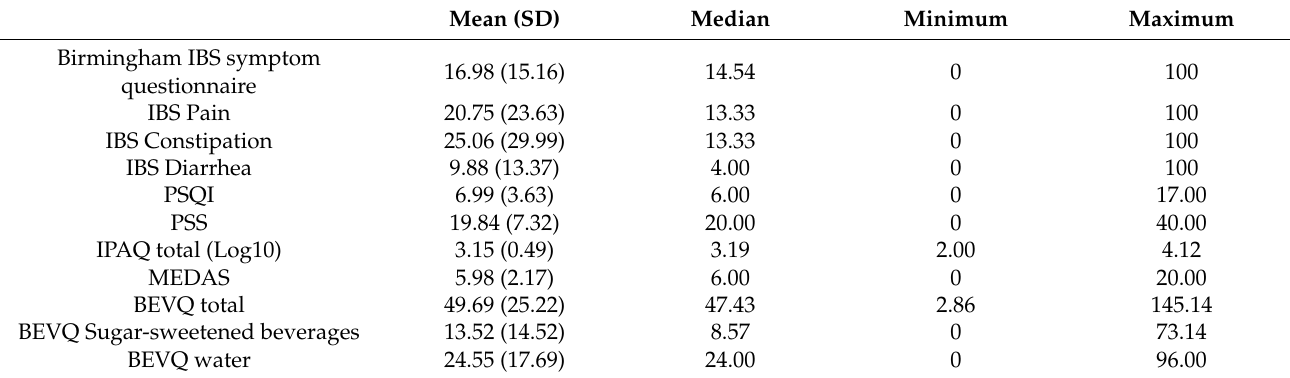
Table 2. Description of the used scales.